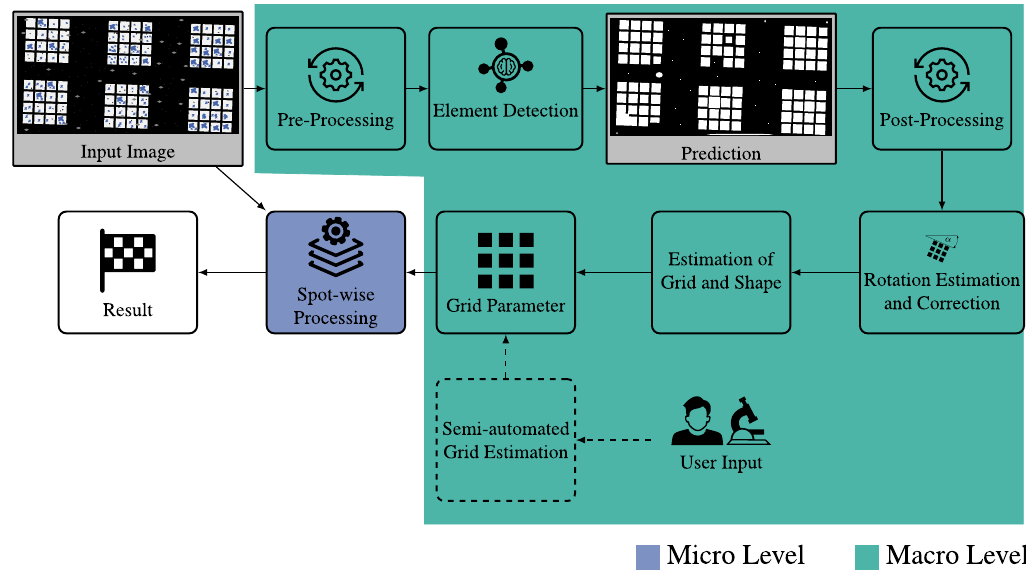
Figure 5. Automated High-throughput Image Processing. The grid parameters are determined at the macro level ( ) by pre-processing an input image to enhance the subsequent element detection based on DL, using the post-processed predicted segments to estimate/correct the grid rotation (cf. Sect. “Automated high-throughput image processing”). Besides, semi-automated grid estimation (dashed) is possible. The macro level is followed by spotwise-processing (cf. Sect. “Automated high-throughput image processing”) at the micro level ( ) 32 .